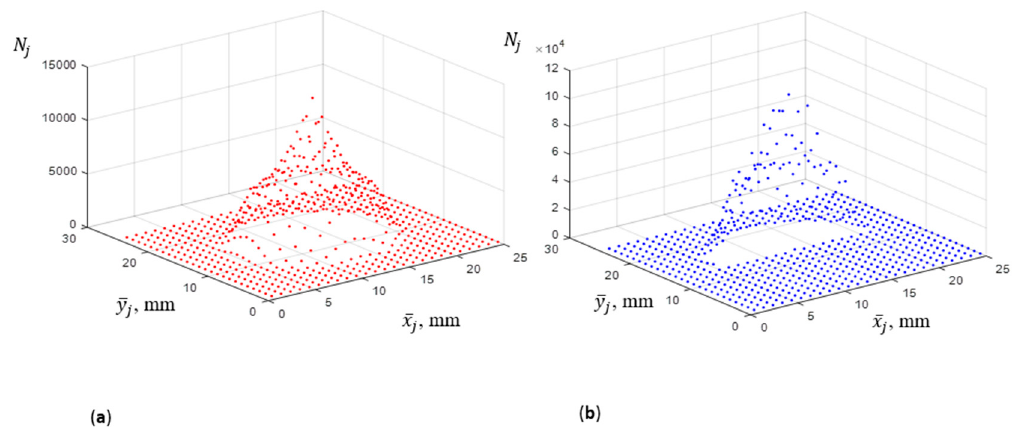
Figure 2. ( a ) Ray distribution on the FPA when the instrument is regarding a blackbody and ( b ) ray distribution with one-half of the aperture occluded while regarding the same